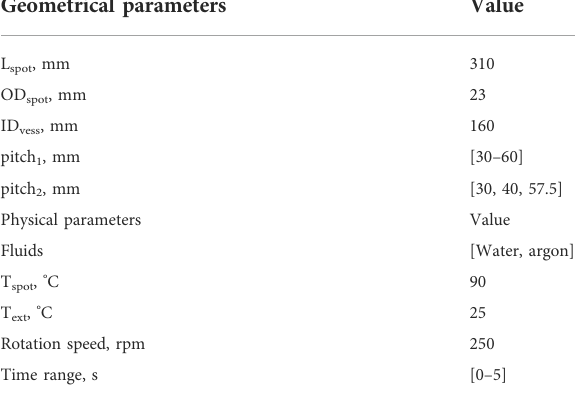
TABLE 1 Geometrical and physical parameters of the